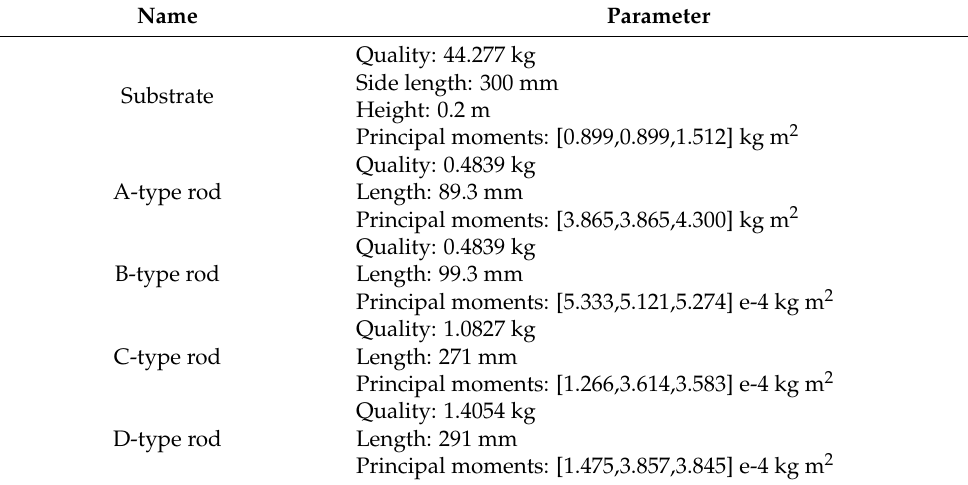
Table 1. Space dobby robot